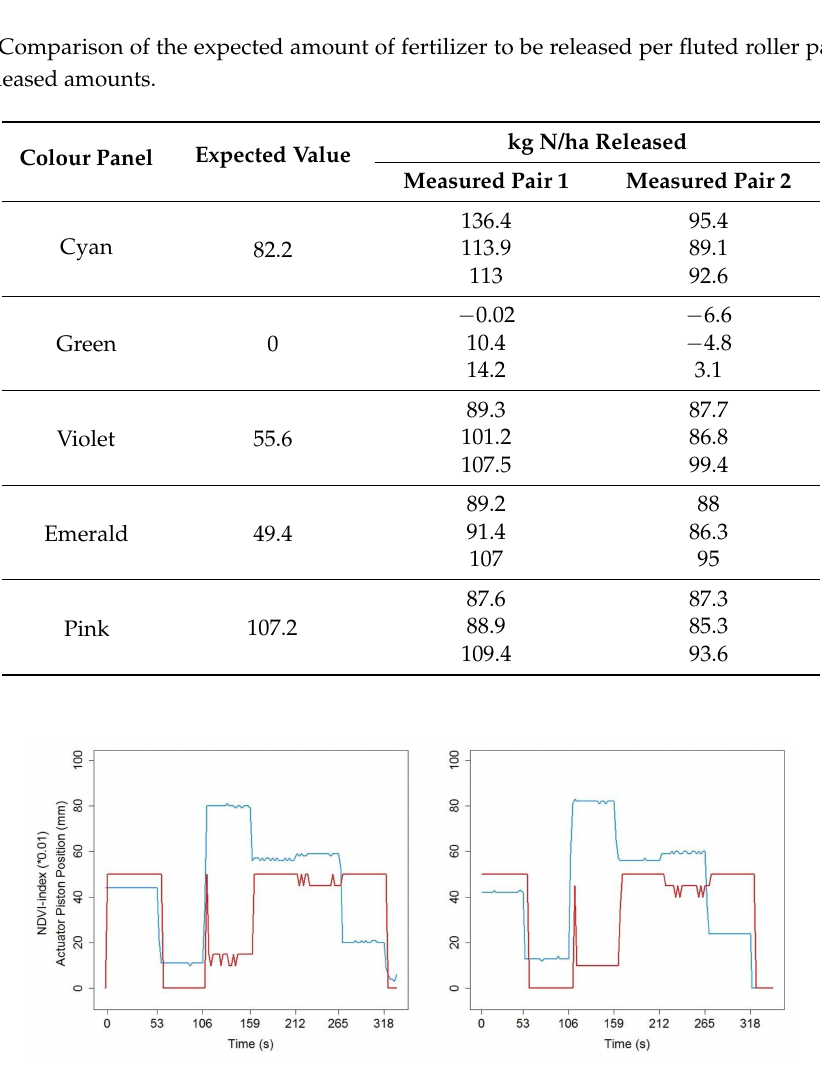
Figure 6. Link between N-sensor 1 ( left ) and N-sensor 2 ( right ) and corresponding actuator movements during the test for GDD 432-RS 0.90. N-sensor processed data are represented in blue and the reaction of the actuator piston in red, measured in